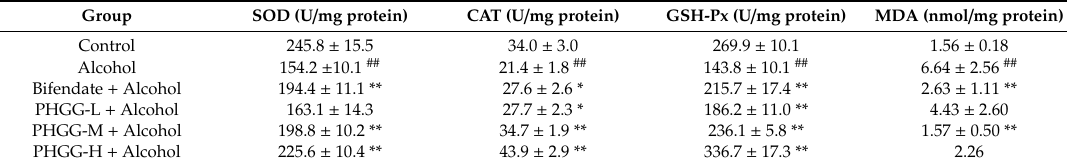
Table 2. E ff ect of partially hydrolyzed guar gum (PHGG) treatment on lipid peroxidation and antioxidant status in